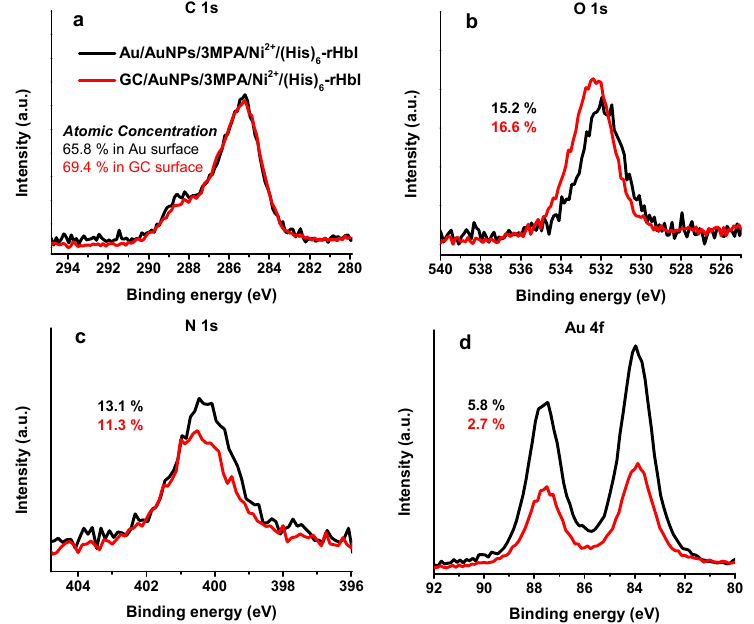
Figure 7. XPS-HRS of glassy carbon (red line) and gold (black line) surfaces modified with AuNPs/3MPA/Ni 2+ /(His) 6 -rHbI using Mg K α X-ray source of ( a ) C 1s, ( b ) O 1s, ( c ) N 1s, and ( d ) Au 4f regions.